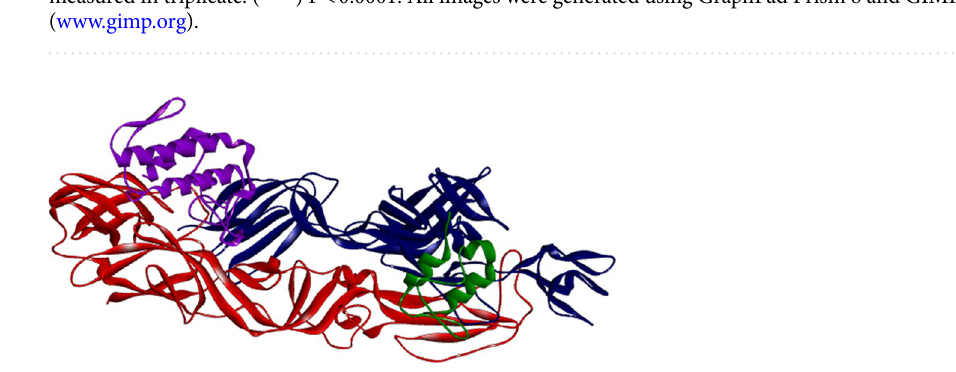
Figure 5. Molecular docking suggests possible interactions between PLA2CB and CHIKV glycoproteins. The post-docking 3D image was generated in the DS Visualizer program (Dassault Systèmes BIOVIA, Discovery Studio Visualizer, 2016). The CHIKV envelope glycoproteins E1 (Red), E2 (Blue), E3 (green), complexed with PLA2 CB (purple) are shown. All images were generated using GraphPad Prism 8 and GIMP 2.10.20 (www. gimp.